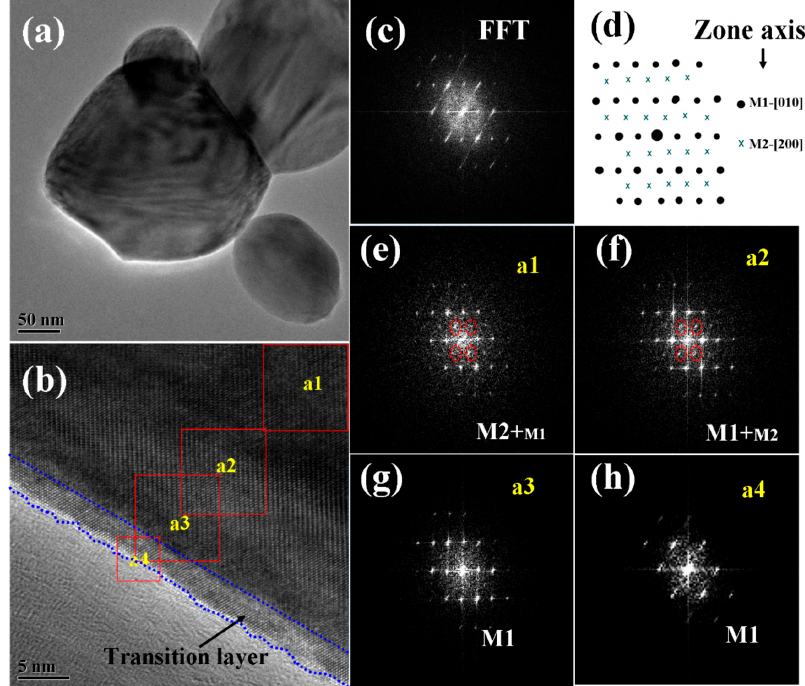
Figure 5. Low magnification TEM ( a ), HRTEM ( b ), and FFT patterns for the total ( c ) and the selected areas ( e – h ) of a VO 2 nanopyramid particle. The region marked with dotted blue lines in ( b ) shows the oxygen rich transition layer. ( d ) shows the demonstration of simulated diffraction patterns for VO 2 M1 and M2, from zone axes of M1-[010] and M2-[200], respectively. As reported by others [53,55,56], the M2 phase is another monoclinic phase of VO 2 with a free energy close to that of M1, which can be stabilized by doping [55] or compressive uniaxial stress in the R-[110] direction [56] (equivalent to a tensile strain along the c axis in R phase or a axis in the M1 phase). Considering the XRD results (Figure 1) where the diffraction patterns of M1 phase VO 2 (011) (or R phase VO 2 (110)) shifted toward high angles, a compressing stress along the R-[110] (or M1-[011]) direction can be expected, which will be favorable for stabilizing the metastable M2 phase. Moreover, the M2 phase has also been reported to be related with the incorporation of V 5+ ions in the crystal lattices (by lower valence Cr 3+ doping [55], or non-stoichiometric engineering caused by annealing in an oxygen-rich condition [57]). From the high-resolution TEM image in Figure 5b, we could see a distinct thin transition layer on the surface of the pyramidical VO 2 nanoparticle, which had a lower contrast and less rigid lattice fringes when compared with the inside VO 2 crystals, and the FFT pattern for this layer indicated the structure of M1 phase VO 2 . Considering the special oxygen treatment and the XPS results, this thin layer, especially for the outer parts, should be composed of slightly oxidized vanadium-oxide species, which works as an intermediate layer between the oxygen environment and the inside VO 2 crystals in the annealing process. When oxygen is injected into the vacuum tube, the top surfaces of the VO 2 nanoparticles are expected initially to react with the excess O 2 to form oxygen-rich vanadium oxides. The most far-gone form of these oxides is expected to be the highest valence state oxide of V 2 O 5 ( T m , V 2 O 5 = 690 °C), which is highly volatile and can easily evaporate from the surface of the nanoparticles at the annealing temperature of 540 °C (the reaction could be expressed as VO 2 (s) + O 2 → V 2 O 5 (s/l) → V 2 O 5 (g)). In fact, evaporated V 2 O 5 residues with a characteristic orange color can even be observed at the cold end of the quartz tube. The samples obtained with a higher oxygen injection content in our further experiments also confirmed the existence of V 2 O 5 crystals surrounding the VO 2 particles